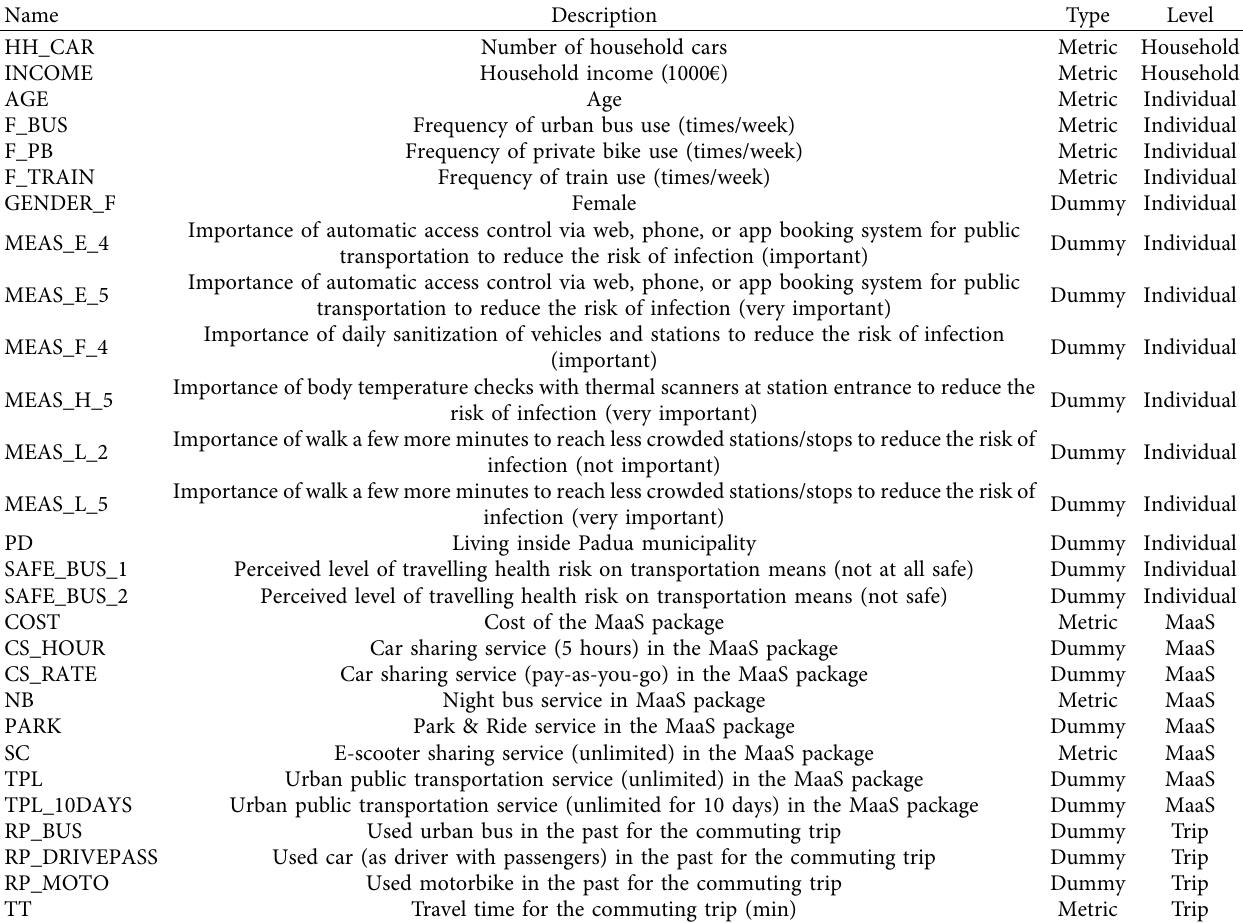
Table 3: Description of exogenous variables used in the MaaS adoption